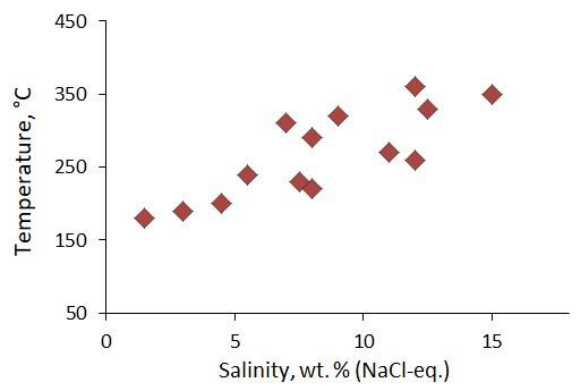
Figure 14. Temperature and salinity variations during quartz vein zones formation at the Dobroe deposit (primary and pseudosecondary FI data).